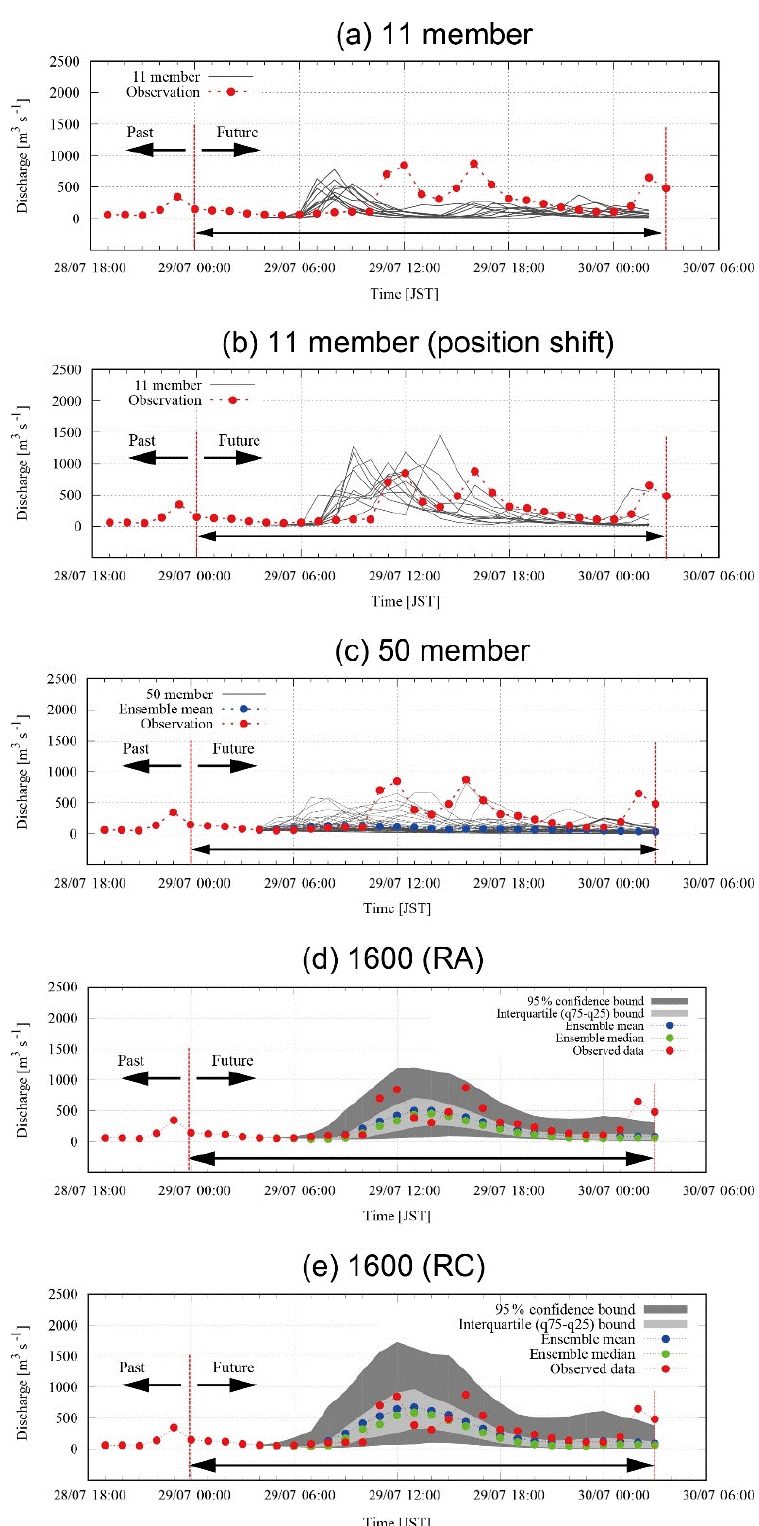
Figure 6. Hydrographs of (a) 11 discharge simulations in Part 1 (Kobayashi et al., 2016), (b) the same 11 members but with a positional shift in Part 1, (c) 50 discharge simulations with 4D-EnVar-NHM and model parameters by RA, (d) 1600 discharge simulations with 4D-EnVar- NHM and model parameters by RA, and (e) 1600 discharge simulations with 4D-EnVar-NHM and model parameters by